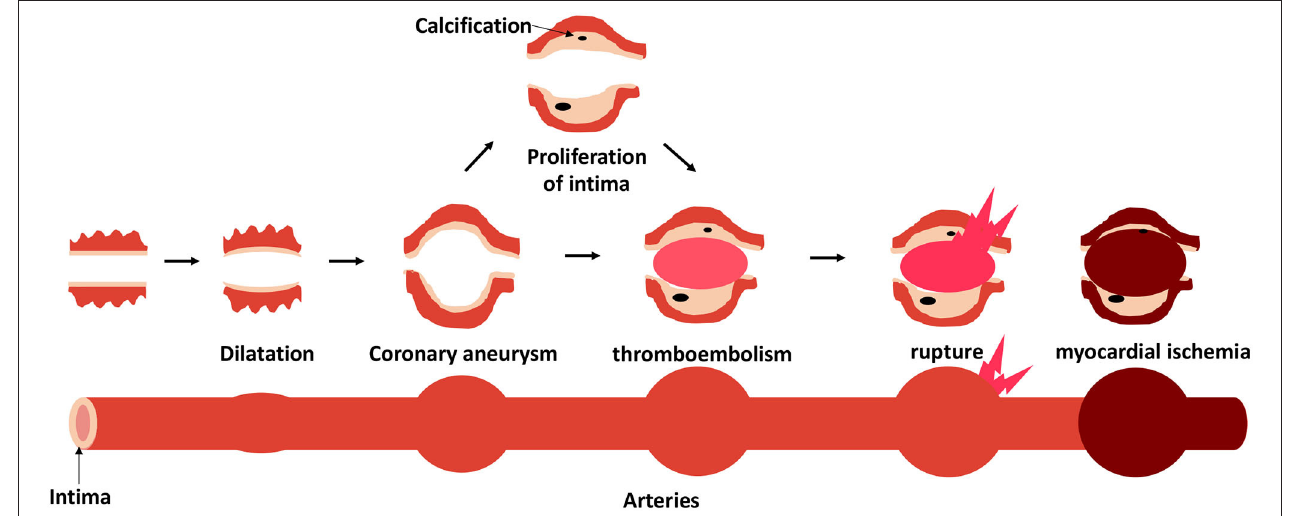
FIGURE 3 | Long-term prognosis of coronary